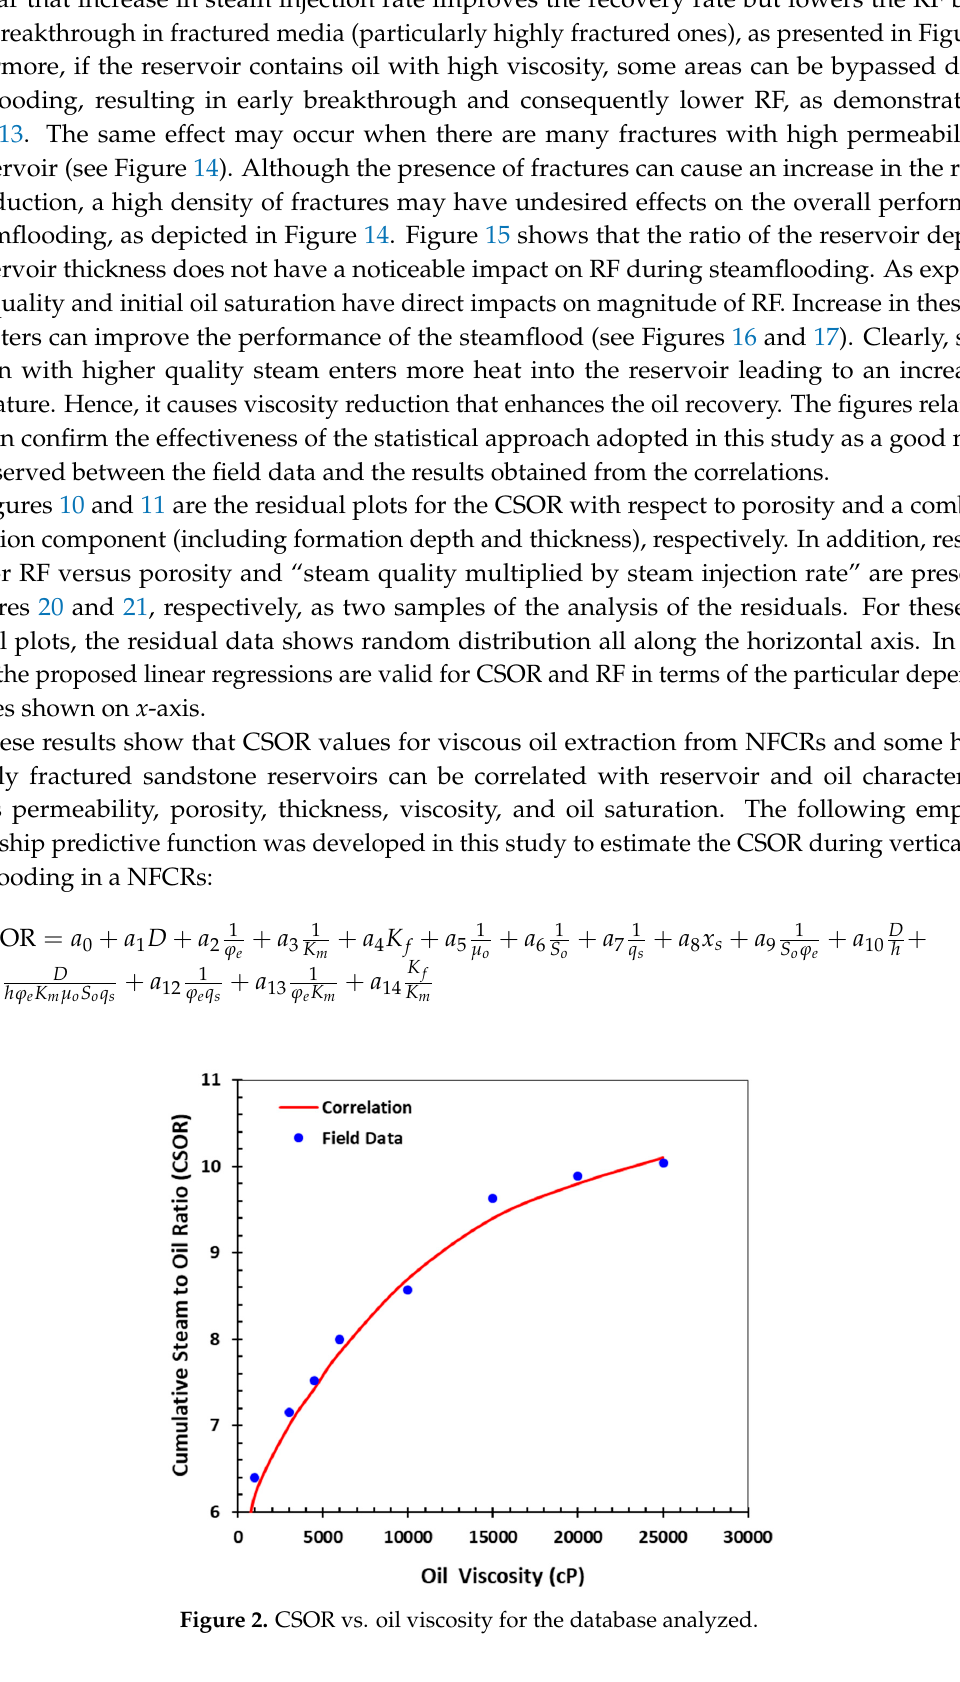
Figure 2. CSOR vs. steam injection rate for the database analyzed.